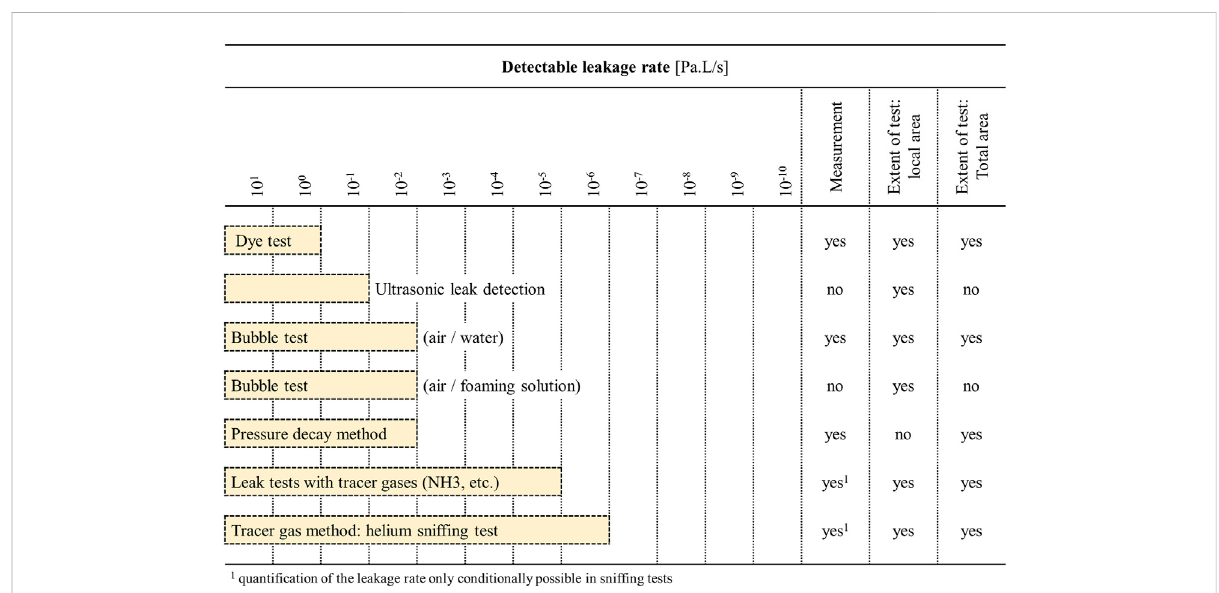
FIGURE 2 Types and detection limits of various leakage detection methods, in terms of changes in pressure over time. Adapted from Schroder